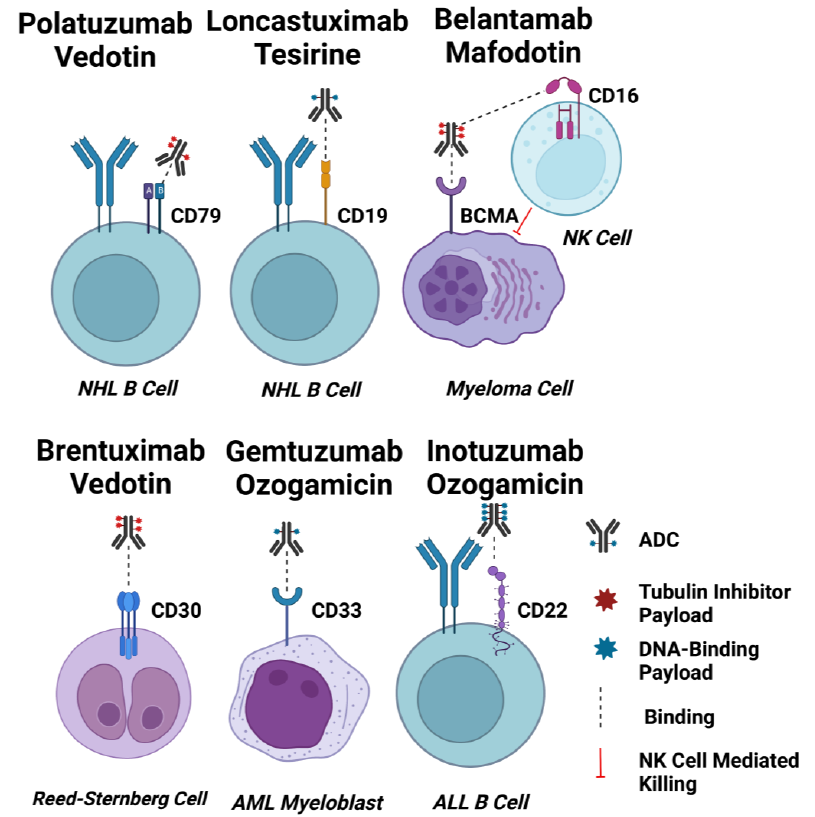
Figure 2. ADC Targets for Haematological Malignancies. Schematic diagrams of EMA and FDA- approved ADCs for haematological cancers binding to their target cells. Approximate drug-antibody ratios for each ADC are represented. ADC payloads that function by tubulin inhibition are shown in red, and DNA-interacting payloads are shown in blue. Dashed lines indicate binding. The effect of afucosylation on belantamab mafodotin is shown by a dashed line indicating enhanced binding to CD16 on an NK cell, and induction of NK cell-mediated killing of target cells indicated by a red line. Created using Biorender.com.